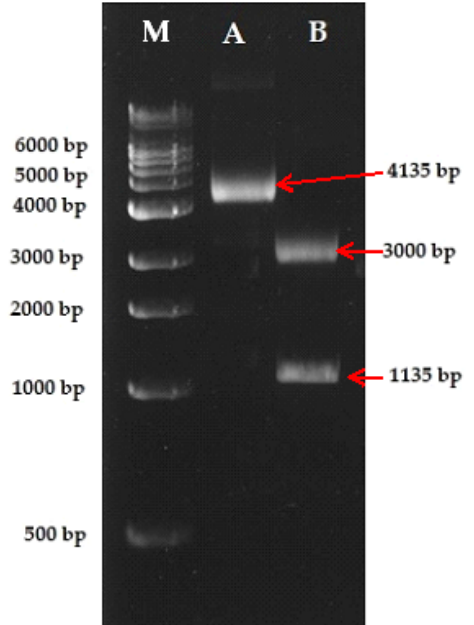
Figure 3. Confirmation of the cloning of the RAPD amplicon in pGEMT-easy vector by restriction digestion. Lane A = cloned RAPD amplicon in pGEMT-easy vector (undigested), Lane B = digestion